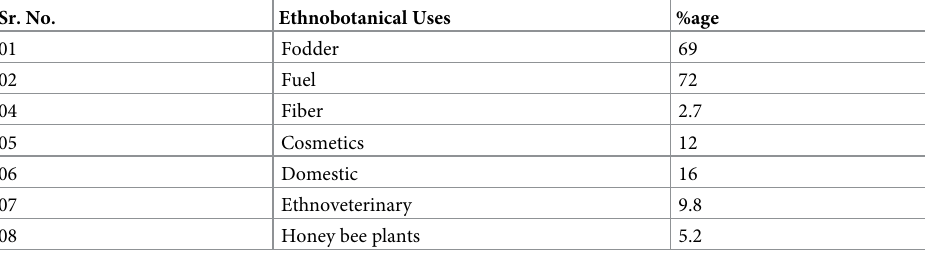
traditional uses and villagers of the area. Among 173 herbal plant species, 69% species were used as fodder, 72% species were used for fuel purpose, 9.8% were used as ethnoveterinary pur- poses, 2.7% were used as fiber, 5.2% were used as honeybee plants, 16% were used as domestic and 12% were used as cosmetics (Table 2 and Fig 2). Similar studies were also conducted by Hussain et al ., 2012 when they studied the ethnobotany of plants (Angiosperm) flora of Rawa- lakot. They represented 173 medicinal plants used by native people for different purposes and cure of human and livestock. About 111 species are weeds, 158 used for fodder, 68 species used as fuel, 33 species were fruit yielding 22 were used as timber, 31 as ornamental, 25 as fenc- ing lawns and fields. While 21 species were used as vegetables, 9 for thatching houses and huts; and 13 species were recorded as poisonous. Shaukat et al ., (2012), studied ethnobotanical stud- ies of diversity of plants of some selected regions of Rawalakot [31]. They concluded that 26 Table 2. Ethnobotanical uses of plants (%age) from Shiwalik mountain range of District Bhimber of Azad Jammu and Kashmir, Pakistan. Sr.